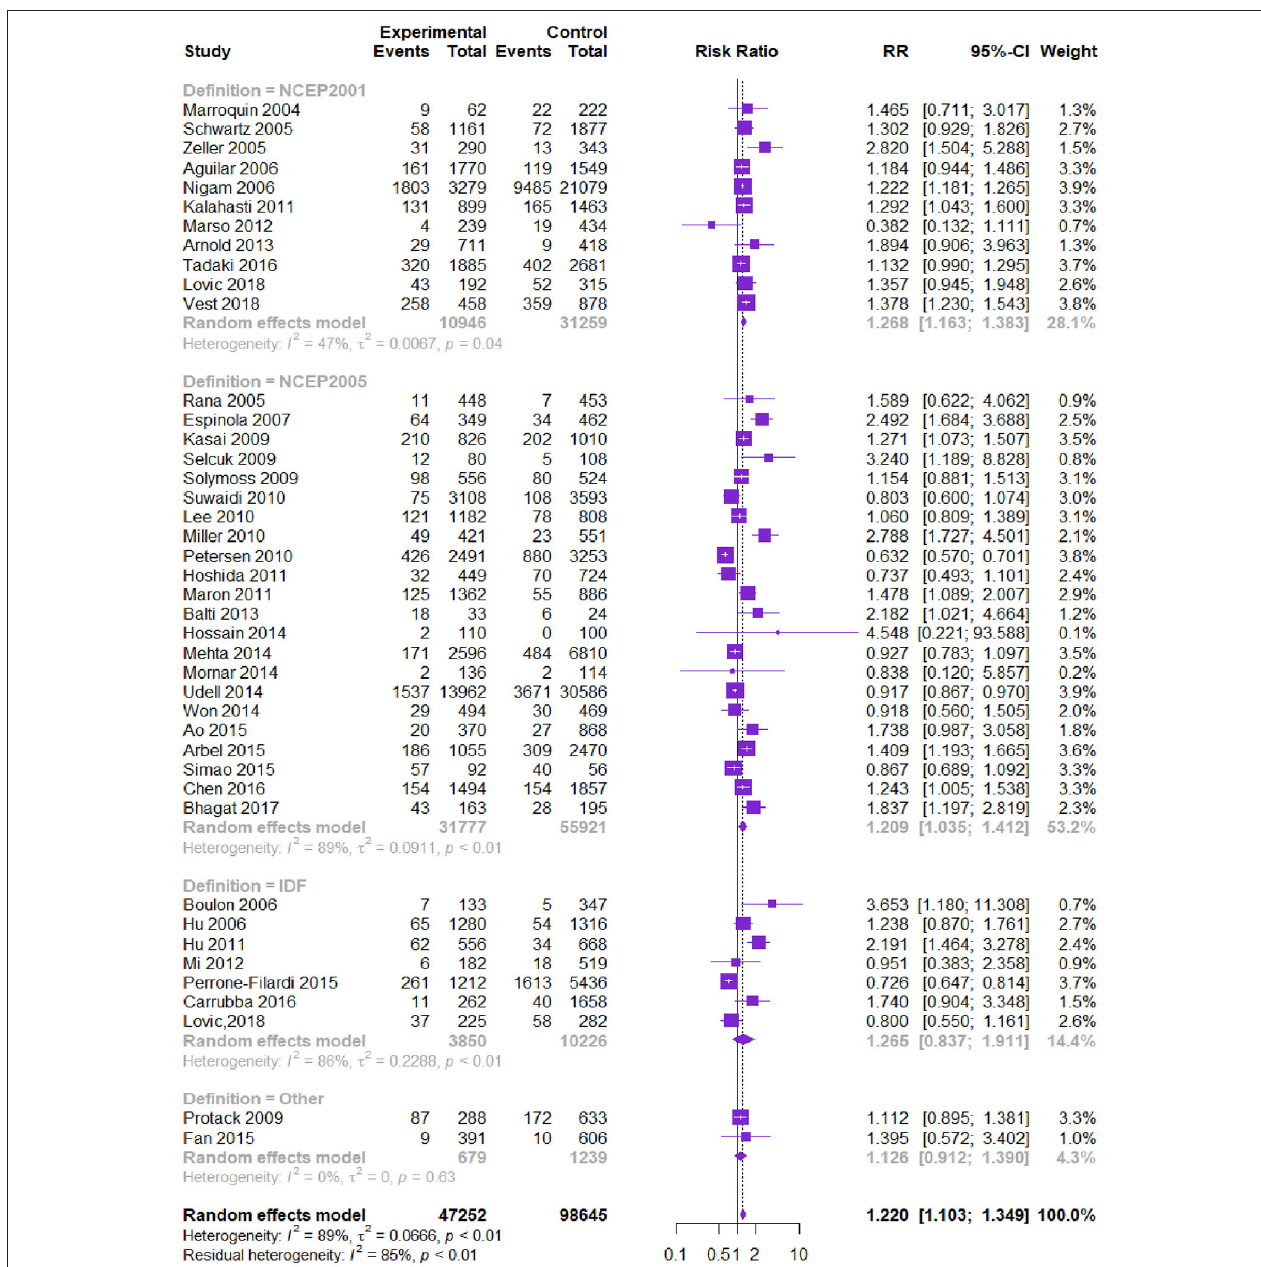
FIGURE 2 | Meta-analysis of the risk of all-cause death in patients with CVD and MetS compared with that of patient without MetS.